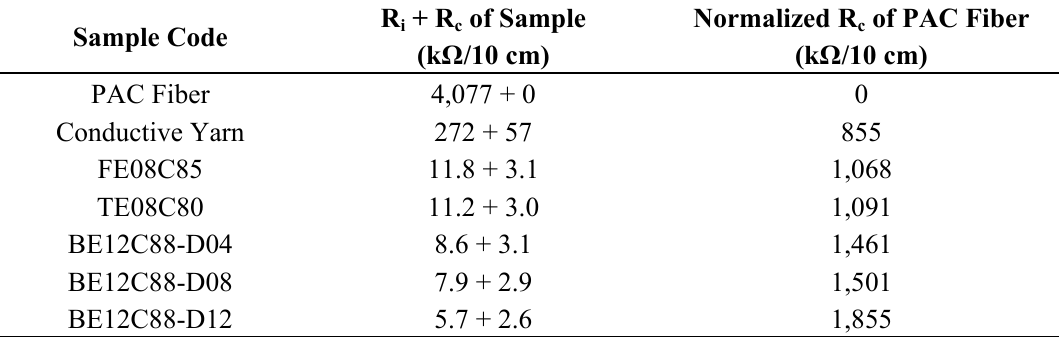
Table 4. Contact resistance of the conductive yarn and